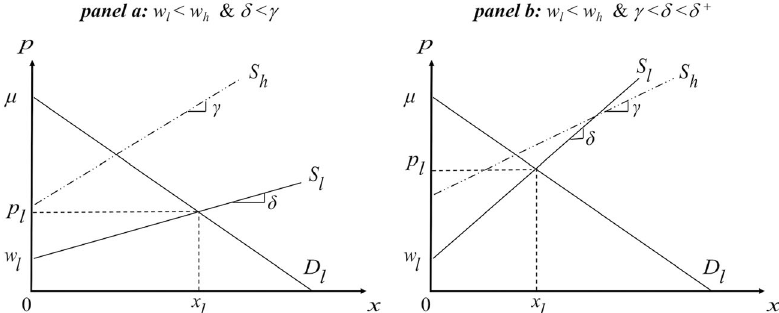
Fig. 2 Equilibrium conditions in Scenario I. This fi gure depicts the demand and supply schedules (and equilibrium conditions) for the two cases that give rise to Scenario I. In both cases, the supply curve for the low-quality product lies below the supply curve for the high-quality product (throughout the relevant range of the demand curve) and the introduction of the undifferentiated low-quality product drives its higher quality counterpart out of the